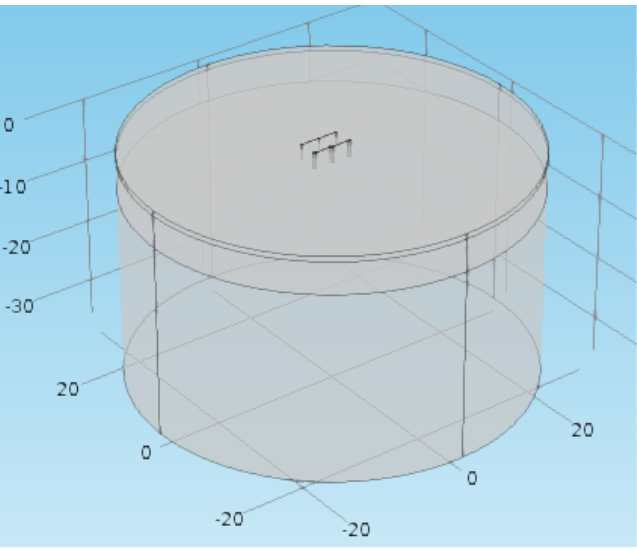
Fig. 6. Building of the soil in FEM simulation software on the grid and their properties.